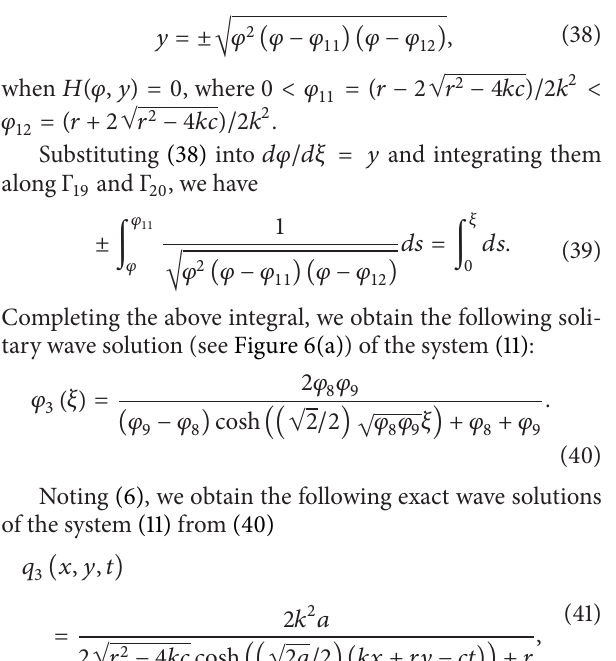
2√𝑘𝑐 < 𝑟 < 4√3𝑘𝑐/3 When (see Figure 2(j)), the expres- sions of the homoclinic orbit Γ 7 and the special orbit Γ 8 passing the points (𝜑 11 , 0) , (0, 0) , and (𝜑 12 , 0) are given as in (𝜑, 𝑦)